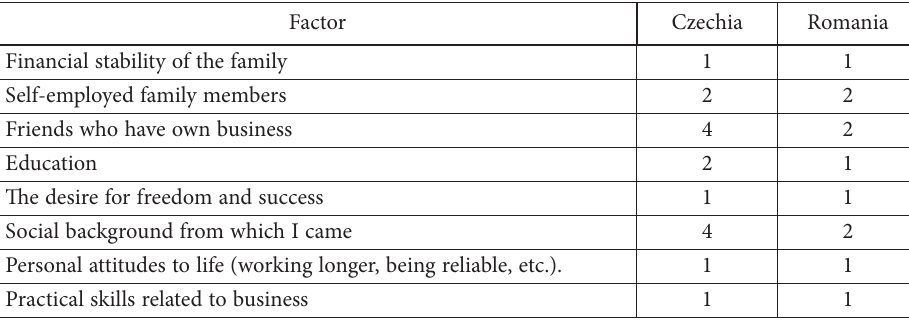
Table 2. Motivation to start-up competencies (source: survey data, compromise solution values, differ- ences are in bold) Factor Czechia Romania Financial stability of the family 1 1 Self-employed family members 2 2 Friends who have own business 4 2 Education 2 1 The desire for freedom and success 1 1 Social background from which I came 4 2 Personal attitudes to life (working longer, being reliable,